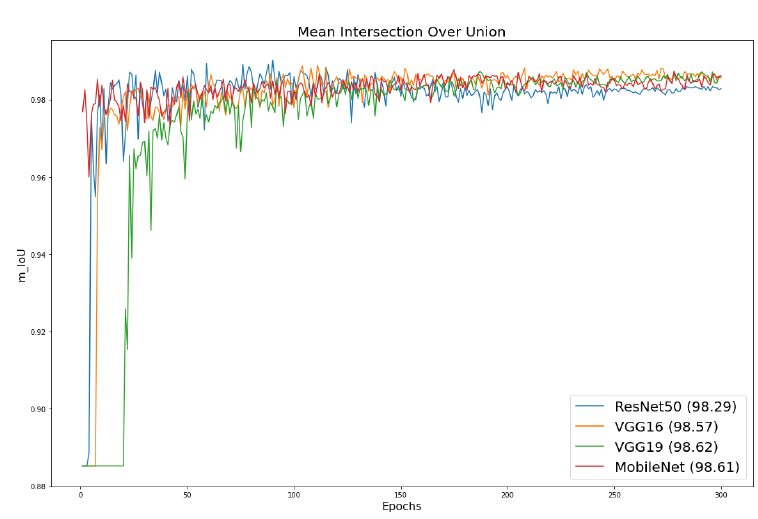
Figure 9. Mean Intersection Over Union of each